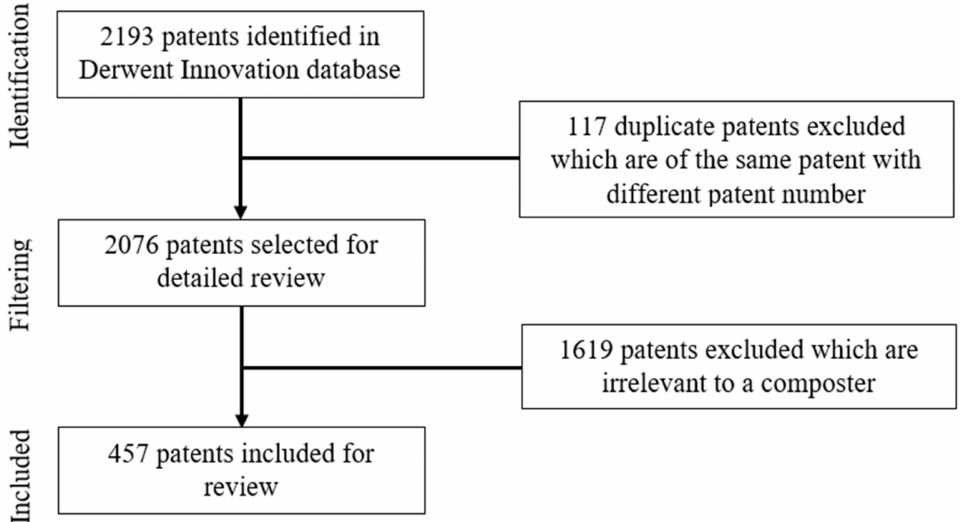
Figure 6. Patent review process in accordance with the PRISMA statement [77].